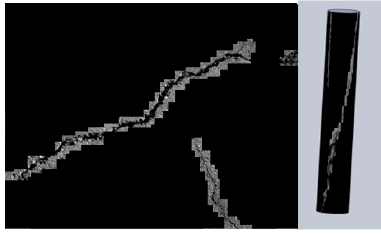
Figure 10. Three-dimensional visualization of cracks corresponding to spatial